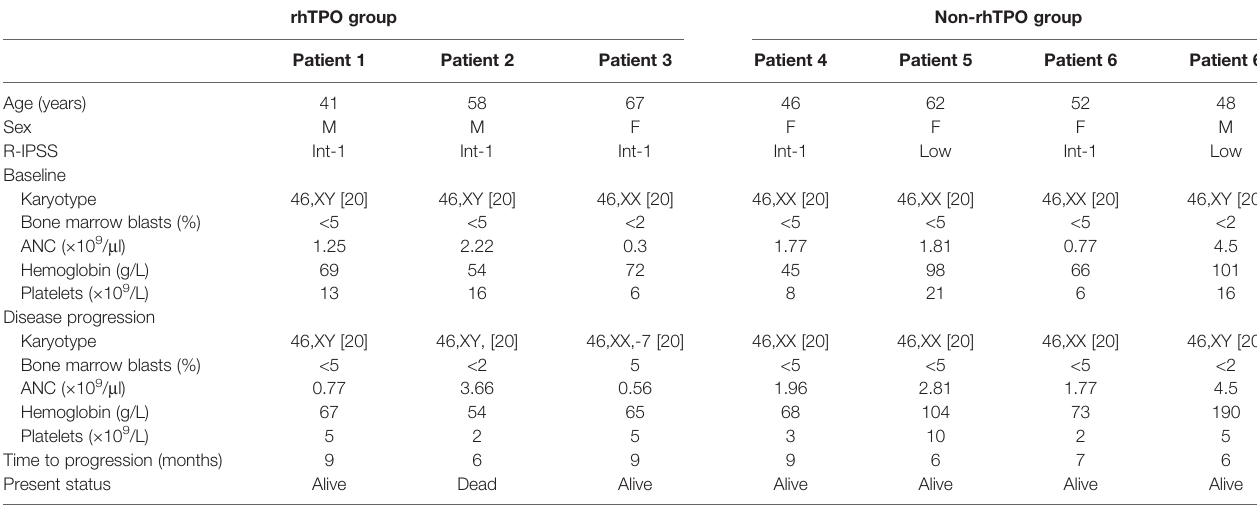
TABLE 3 | Clinical characteristics of patients who progressed during